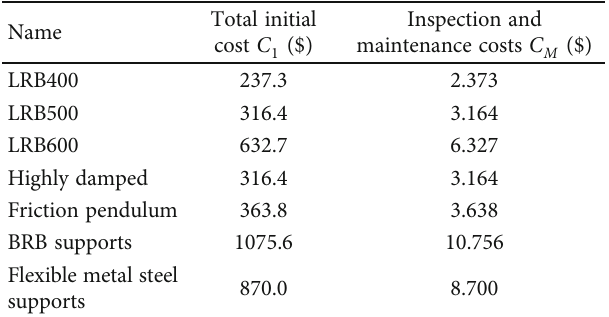
Table 7: Inspection and maintenance fees for each